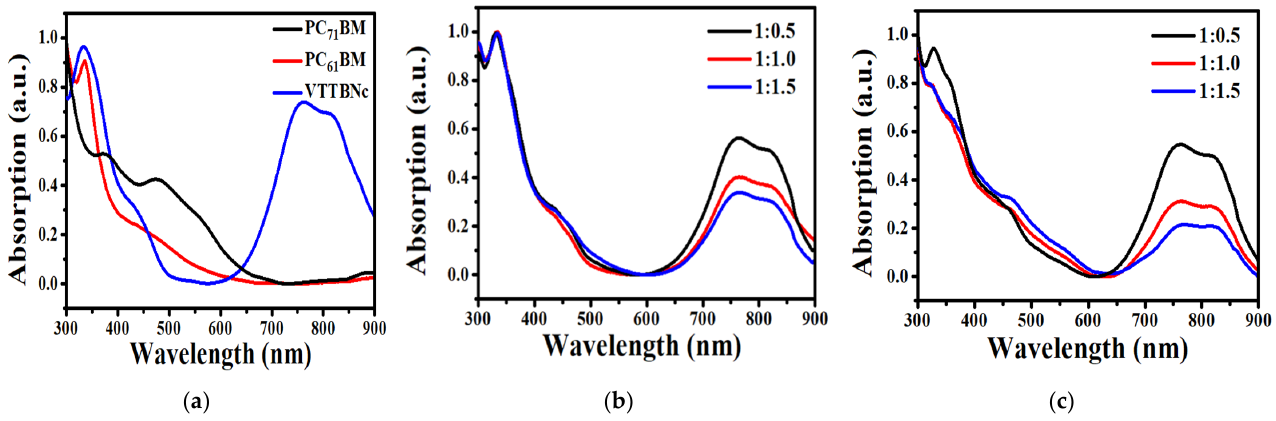
Figure 2. ( a ) Absorption spectra of VTTBNc, PC 61 BM and PC 71 BM thin films. Absorption spectra of ( b ) VTTBNc:PC 61 BM and ( c ) VTTBNc:PC 71 BM of different volumetric ratios.